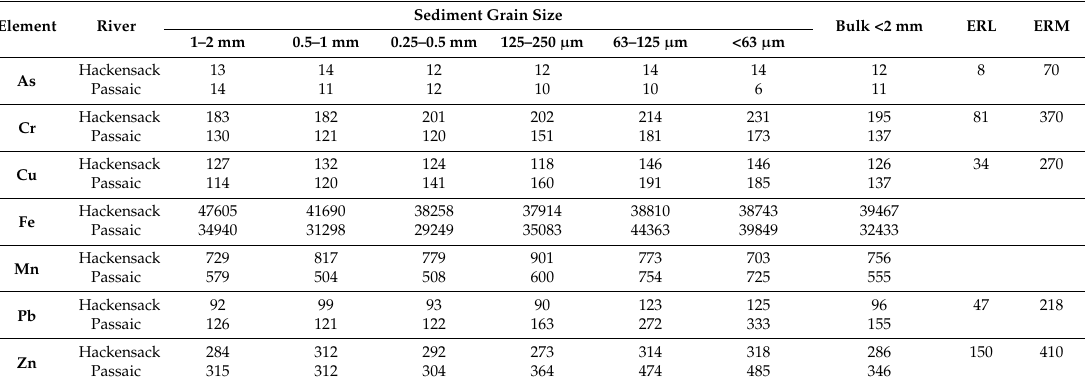
Table 6. Average concentrations (mg/kg) of heavy metals in bulk sediments (<2 mm grain size) and different size fractions of sediments collected from the Hackensack ( n = 8) and Passaic ( n = 7) Rivers in summer 2015. ERL and ERM (the effects range-low and effects range-median, respectively) are sediment quality guidelines